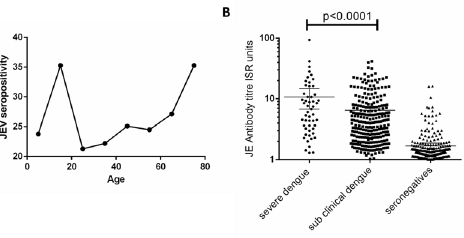
Fig 3. Association of JEV antibody seropositivity with age and severity of past dengue infection. 3A: Association of JEV antibody seropositivity with age. 3B: JE antibody titre of individuals who were hospitalized due to dengue (severe dengue), those who had mild/asymptomatic dengue (subclinical dengue) and dengue seronegative individuals.